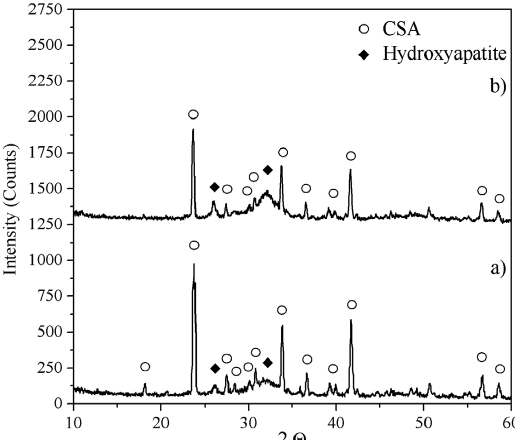
Figure 5. XRD patterns of CSAC after immersion in SBF for (a) 14 and (b) 21 days.